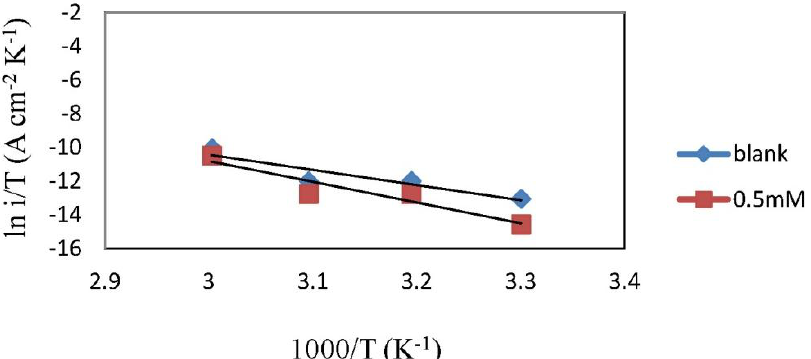
Figure 6. Transition state plots for mild steel in 1.0 M